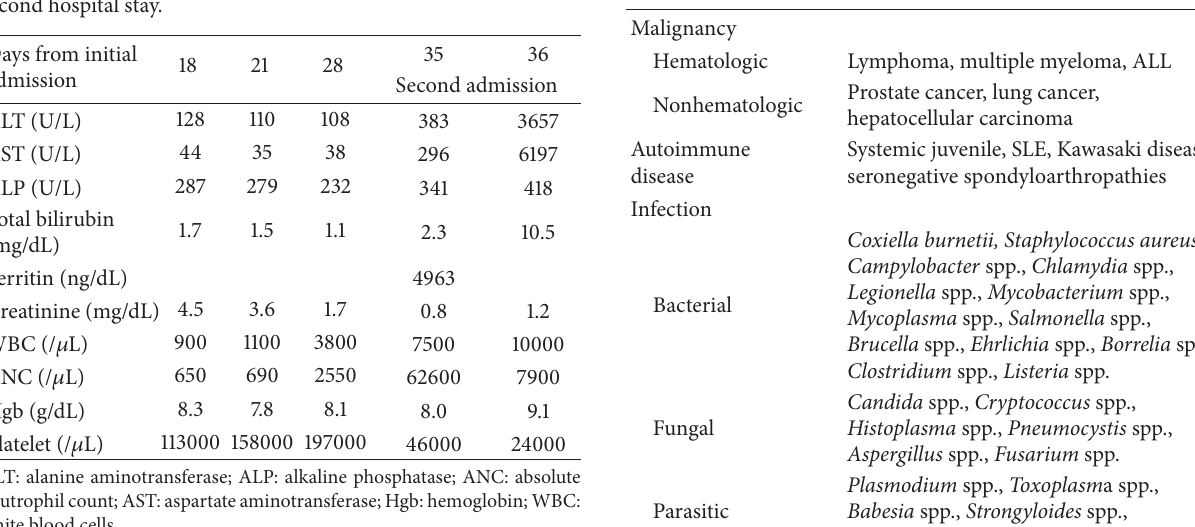
Table 3: Etiologies associated with secondary